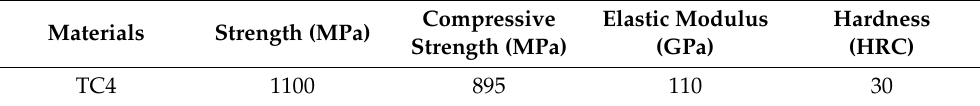
Table 2. Mechanical properties of